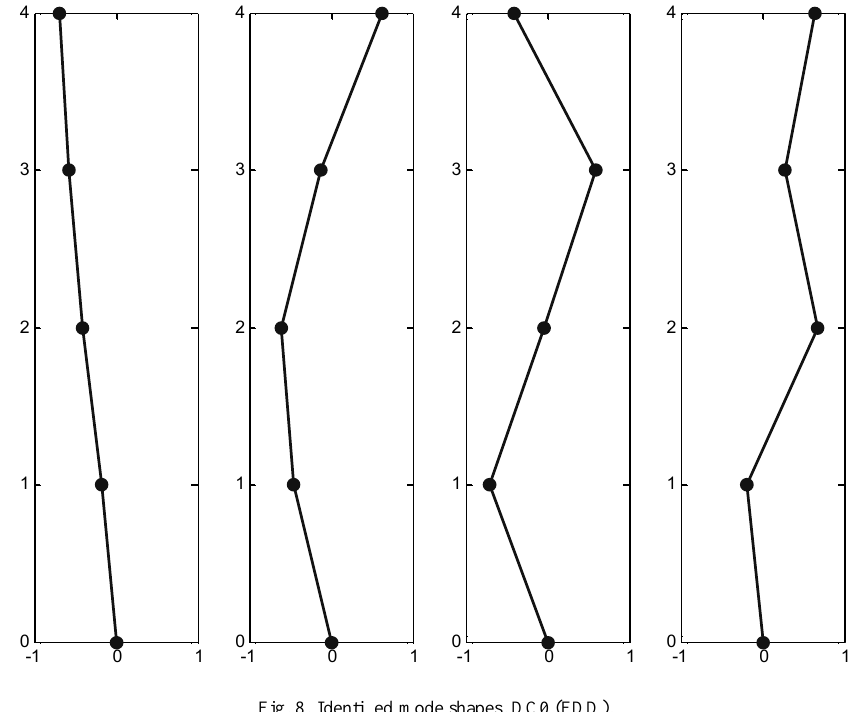
Fig. 8. Identified mode shapes, DC0